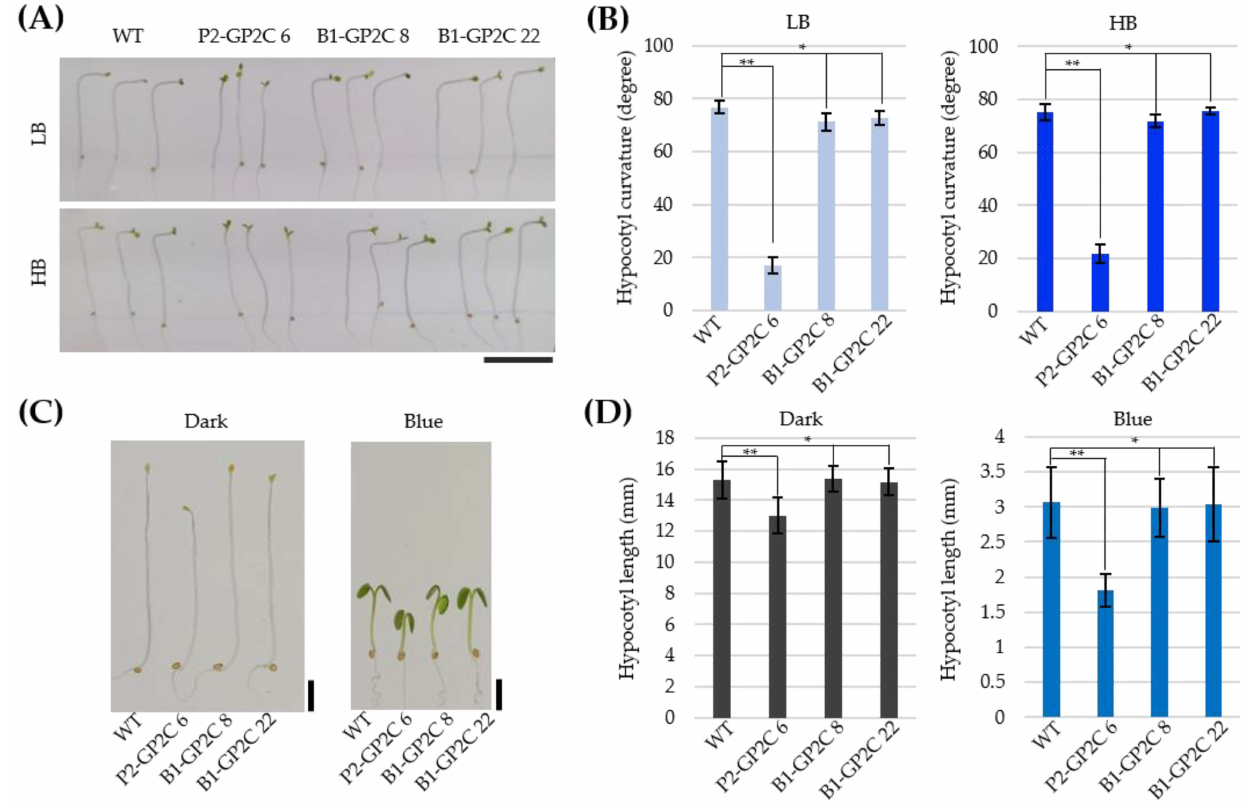
Figure 3. Hypocotyl growth and phototropic responses in WT, P2-GP2C, and B1-GP2C plants. ( A ) Photos showing the phototropic phenotypes of WT, P2-GP2C, and B1-GP2C plants. Three- day-old dark grown Arabidopsis seedlings were irradiated with low intensity of blue light (LB, 2 µ mol m − 2 s − 1 ) and high intensity of blue light (HB, 40 µ mol m − 2 s − 1 ) for 16 h. Scale bar = 1 cm. ( B ) Phototropic curvature was measured as the change in hypocotyl angle as determined from an analysis of stacked images of ( A ). Data represent the mean ± SE ( n = 15). ( C ) WT, P2-GP2C, and B1-GP2C seedlings were grown in the dark or blue light (10 µ mol m − 2 s − 1 ) for 5 days. Scale bars = 2 mm. ( D ) Quantitative analyses of the hypocotyl length of seedlings shown in ( C ). Data represent the mean ± SE of three independent experiments ( n > 25). Asterisks indicate statistical differences detected by Student’s t -test (* not significant p > 0.05; ** significant p <